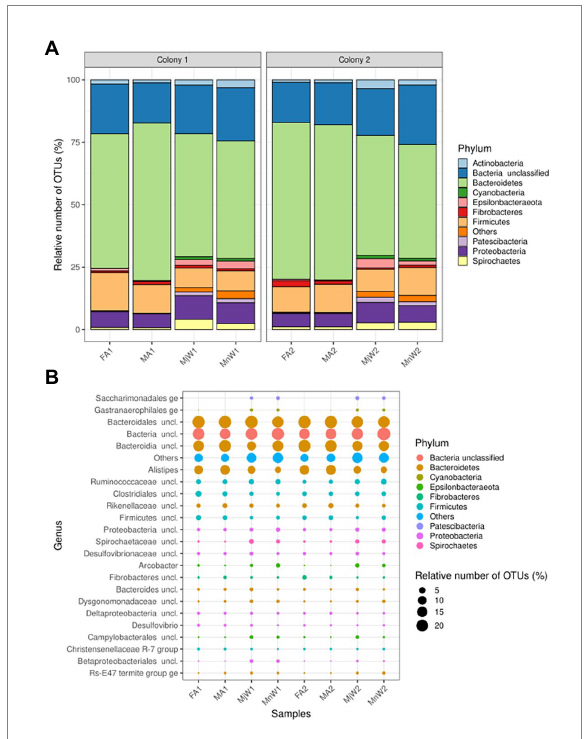
FIGURE 2 Phylum-level (A) and genus-level (B) distribution of bacterial OTUs in the gut of female alates (FA), male alates (MA), major workers (MjW) and minor workers (MnW) of Macrotermes subhyalinus from two distinct wild colonies. For both taxonomic levels, only taxa covering a number of OTUs >0.5% of the total number of OTUs of the dataset are displayed. The corresponding taxa covered >97% of OTUs in each library for the phylum-level and > 85% of OTUs for the genus-level. “Others” refers to the cumulative percentage of the remaining OTUs. The dot sizes are proportional to the relative number of OTUs for the corresponding taxa in each